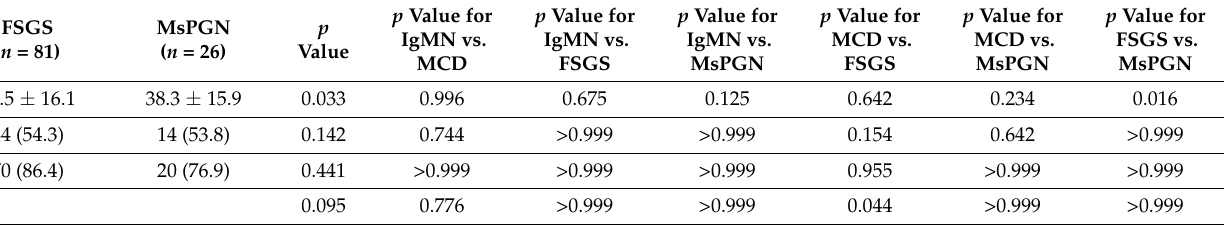
Table 1. Clinical characteristics of subjects at the time of kidney